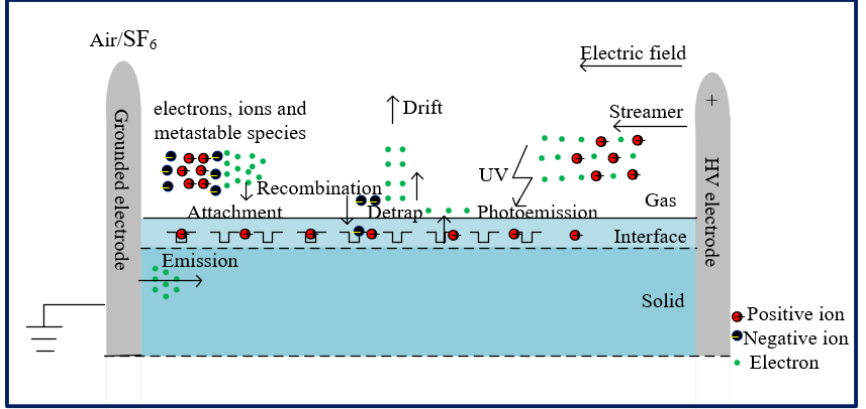
Figure 21. Physical processes involved in flashover under RMPs.